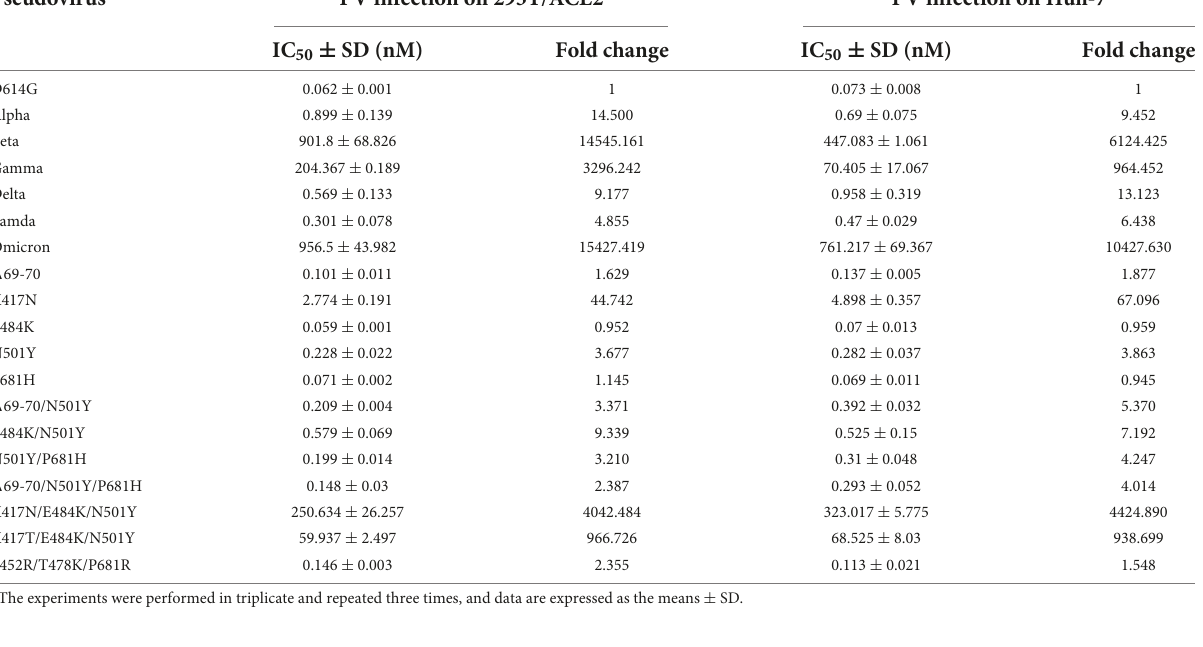
TABLE 1 Resistance profile of SARS-CoV-2 VOCs and related mutants to LCB1 inhibitor a .